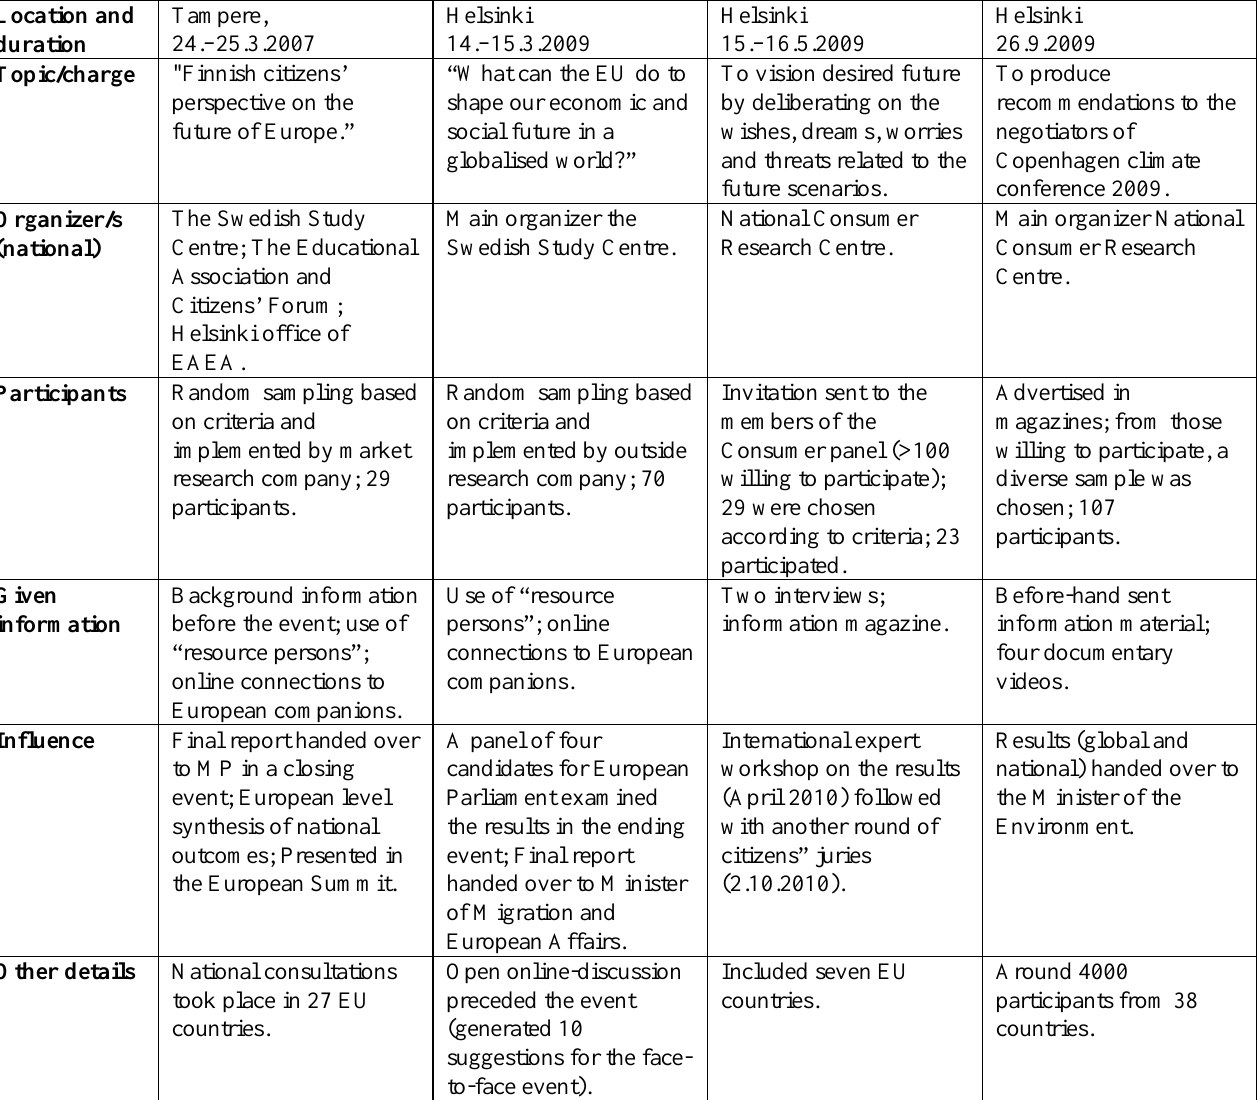
Table 3. Finnish experiments on public deliberation as part of wider international and European projects. (ECC 2007a; ECC 2009; Rask et. al. 2009 ; Niva & Rask 2009